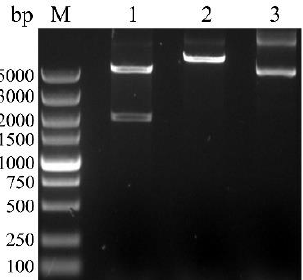
Figure 7. Verification of pET21a-BvAmylase by digestions. M: DNA standard. 1: Double digestion by Bam HI and Xho I. 2: Single digestion by Xho I; 3. Plasmid control.